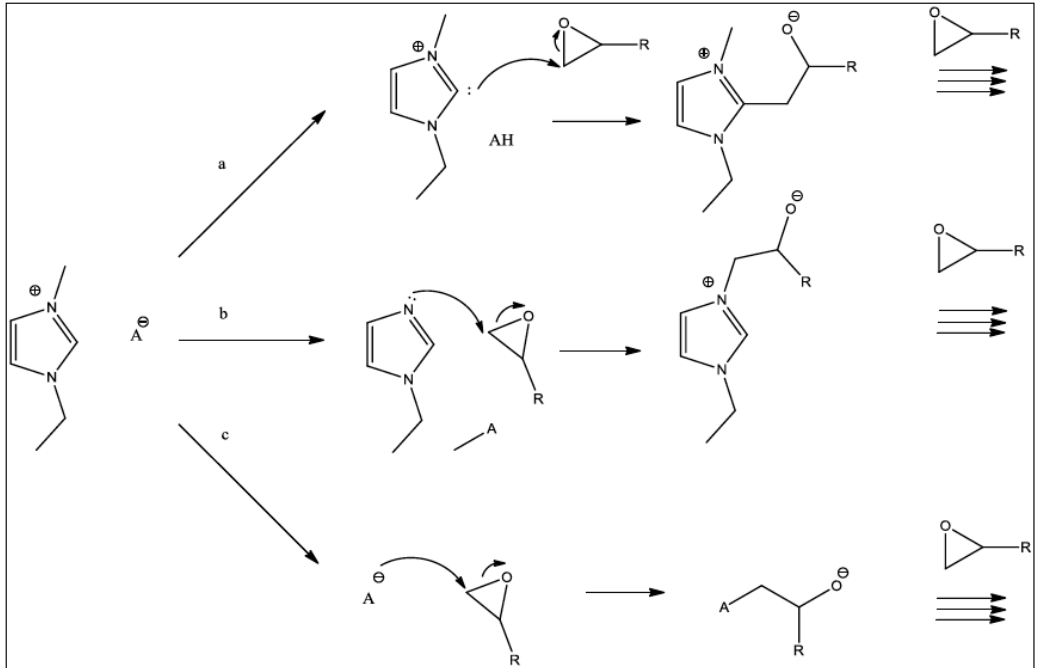
Figure 3. The proposed reaction pathways for the initiation of an epoxy polymerization reaction with imidazolium-based ionic liquids via (a) the “carbene route”, (b) the “imidazole route” and (c) the “counter ion” route.